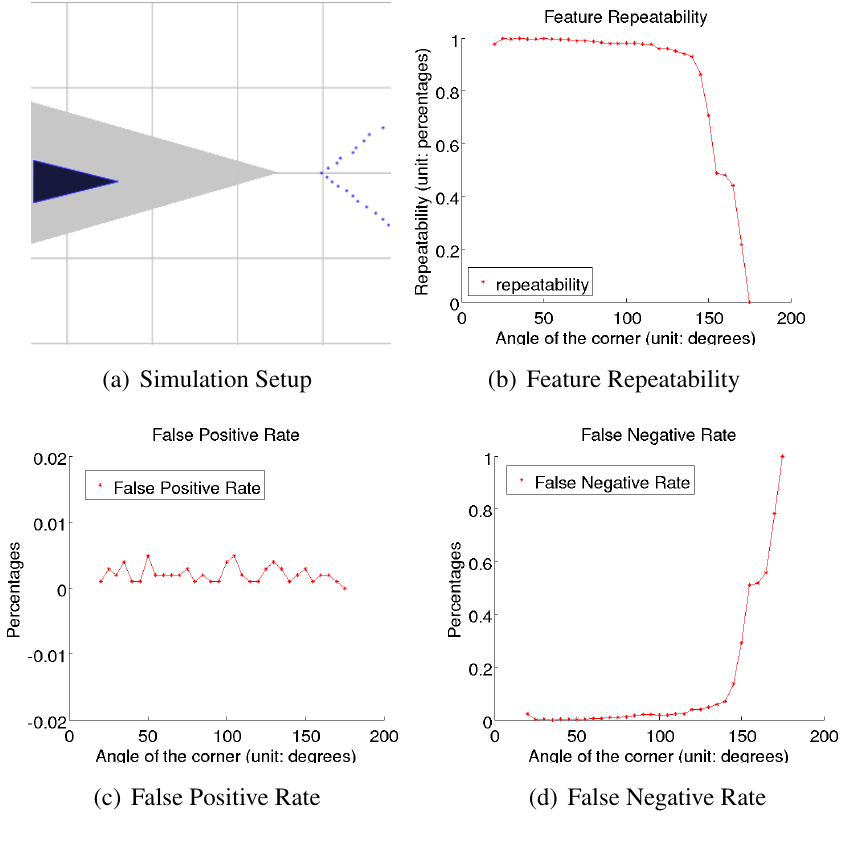
Figure 7. Feature repeatability and detection rates. In (a) , the black triangle denotes the simulated robot position, which was randomly localized in the gray area; blue points are simulated laser scans. In (b) , the red curve indicates the repeatability in the simulation. In (c) and (d) , curvatures indicate the false positive detection rate and the false negative detection rate, respectively.